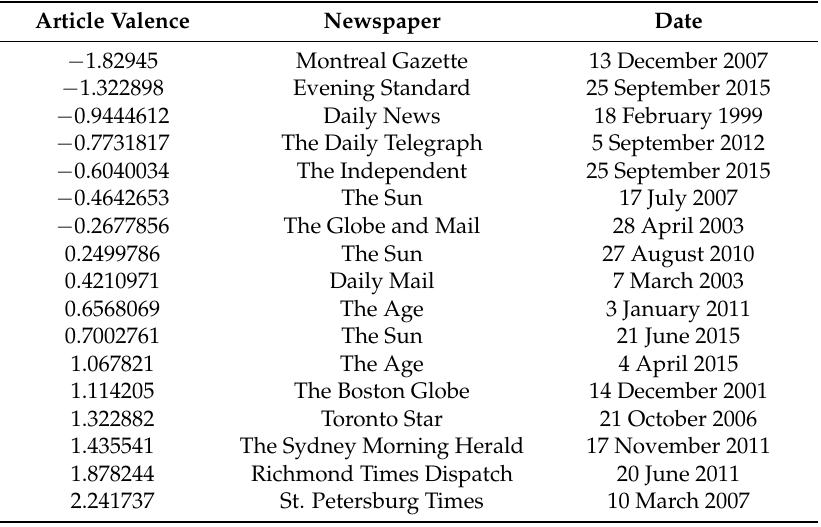
Table A2. Valences for All Newspaper Articles Discussed in the Qualitative